Question: State the chart type depicted above.
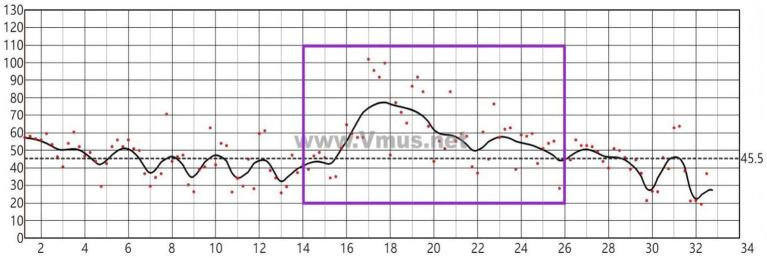
Answer: line